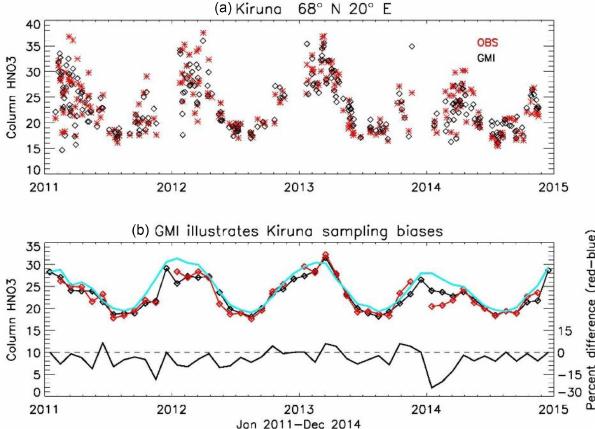
Figure 13. Latitudinal variation of UV-A and erythemal annual dose (a) on a horizontal surface and (b) the ratio of erythemal/UV- A dose. Note that high-altitude stations (South Pole, Mauna Loa, Boulder, Hoher Sonnblick, Summit) receive considerably higher erythemal and UV-A doses than stations closer to sea level (Groß-Enzersdorf, Barrow). Instruments at Melbourne, Darwin, San Diego, and Tokyo are not formally part of NDACC but use the same instrumentation and data processing methods as NDACC- affiliated stations.